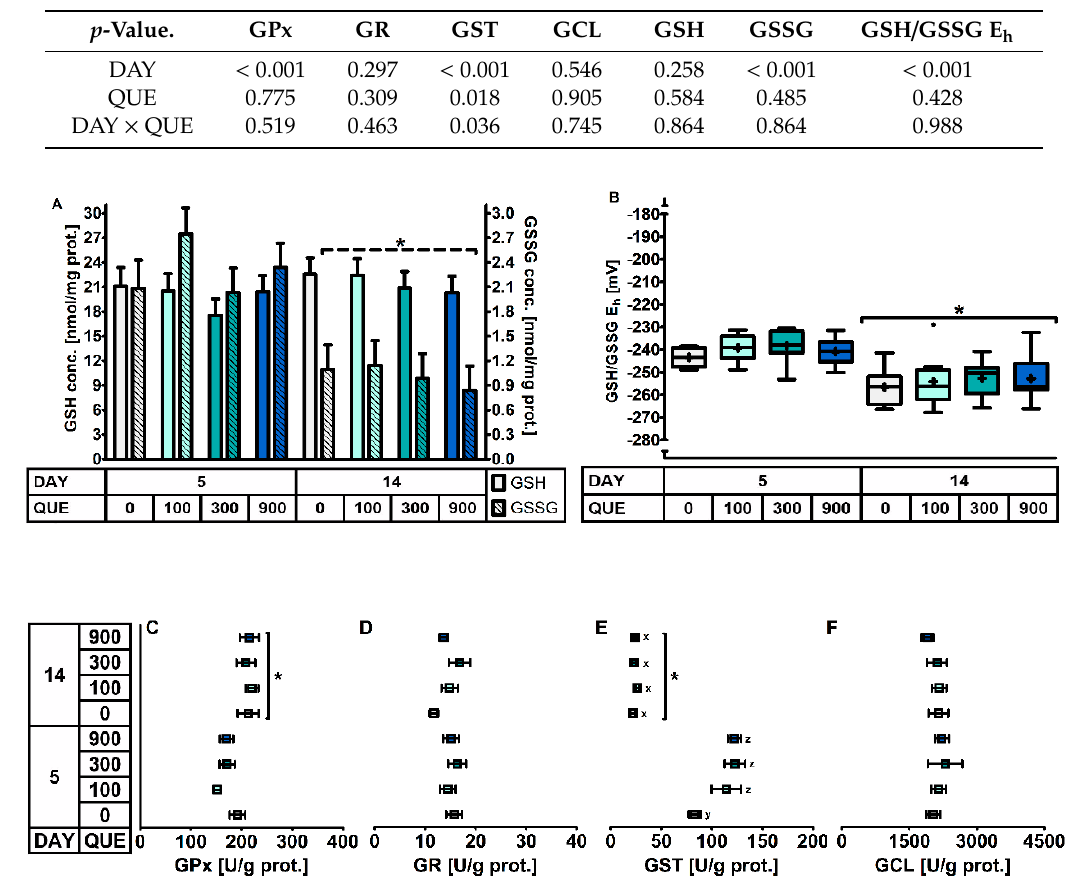
Figure 4. The glutathione redox system in the liver of piglets at d5 and d14 post-weaning (DAY), fed a diet containing either 0, 100, 300, or 900 mg quercetin/kg diet (QUE) during the first 14d post-weaning. Results are presented as least squares means with SD. Significance levels of main effects and interaction terms are presented in Table 7: ( A ) glutathione (GSH) and glutathione disulphide (GSSG)